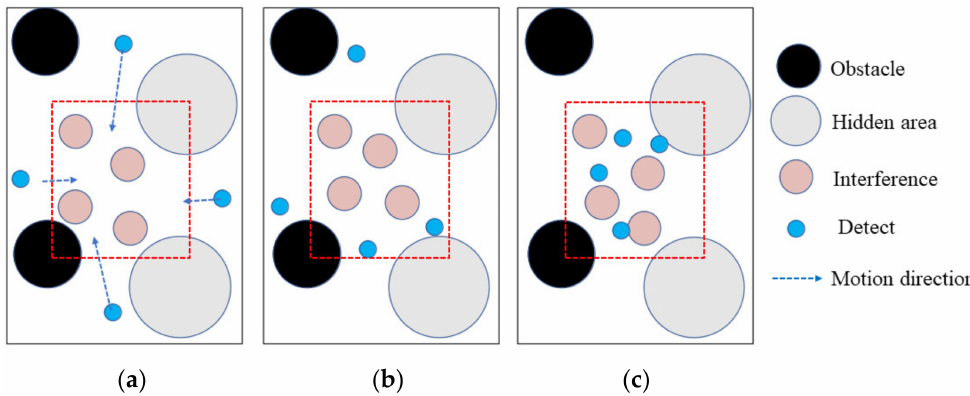
Figure 4. Prediction experiment: ( a ) shows the movement trend in the pre-training period of detection agents, ( b ) shows the effect in the middle of the training period, and ( c ) shows the action results after